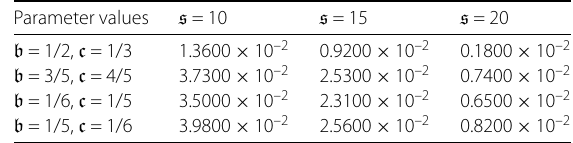
Table 1 Absolute error in boundary conditions of x ( t ) of Example 6.1 for different values of parameters b and c